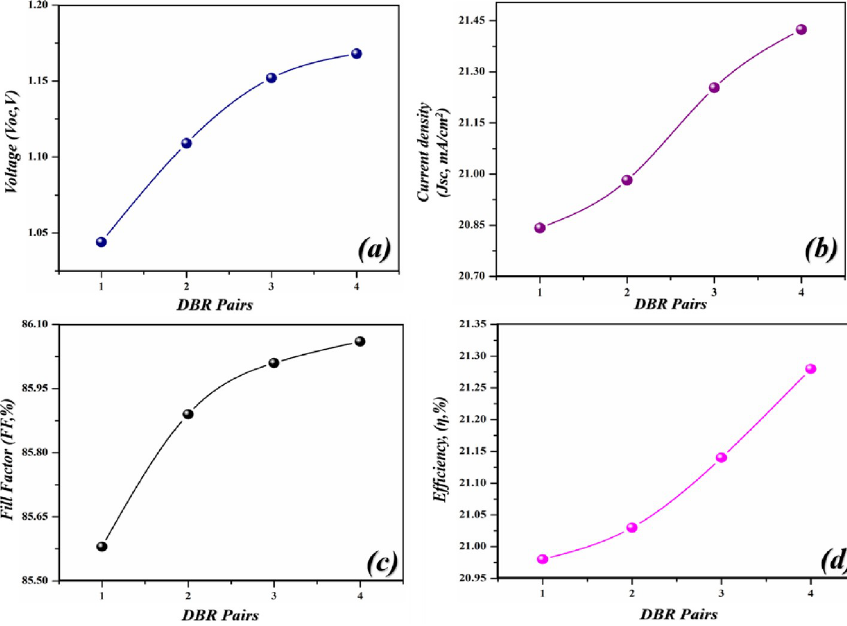
Fig 11. Simulated photovoltaic parameters of novel geometry with different DBR pairs (Si/SiO 2 ) (a) V oc as an independent function of light-harvesting layer, (b) J as an independent function of the light-harvesting layer (c) FF as sc an independent function of light-harvesting layer (d) PCE as an independent function of light-harvesting layer.